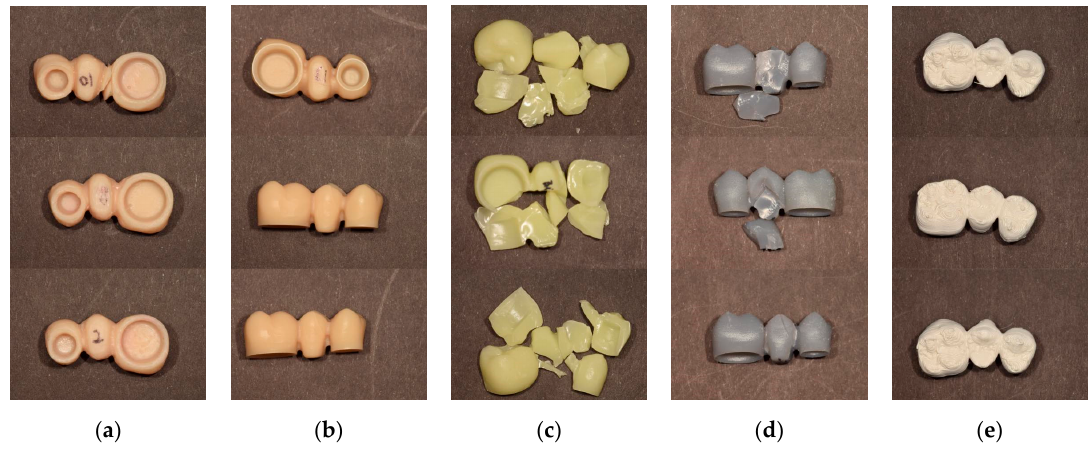
Figure 6. Fracture pattern of each specimen. ( a ) CV; ( b ) SM; ( c ) DLP; ( d ) SLA; ( e ) FDM. Table 3. Classification of characteristic patterns of cracks and fractures.